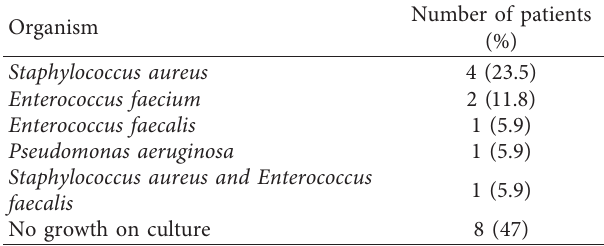
Table 3: Microorganisms isolated from blood cultures in IE pa- tients ( n � 17).